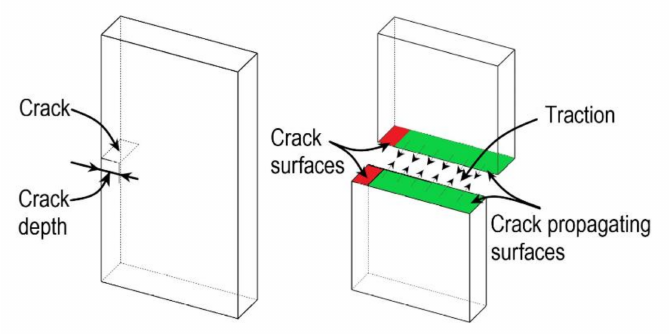
Figure 7. Cracked